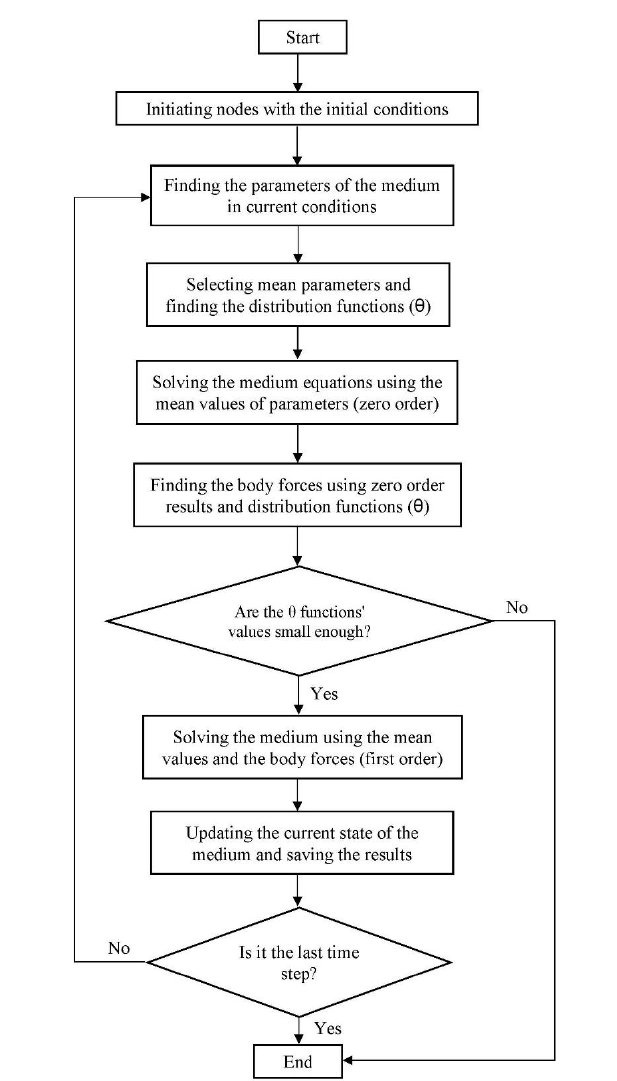
Figure 1: The Flowchart of the computational algorithm